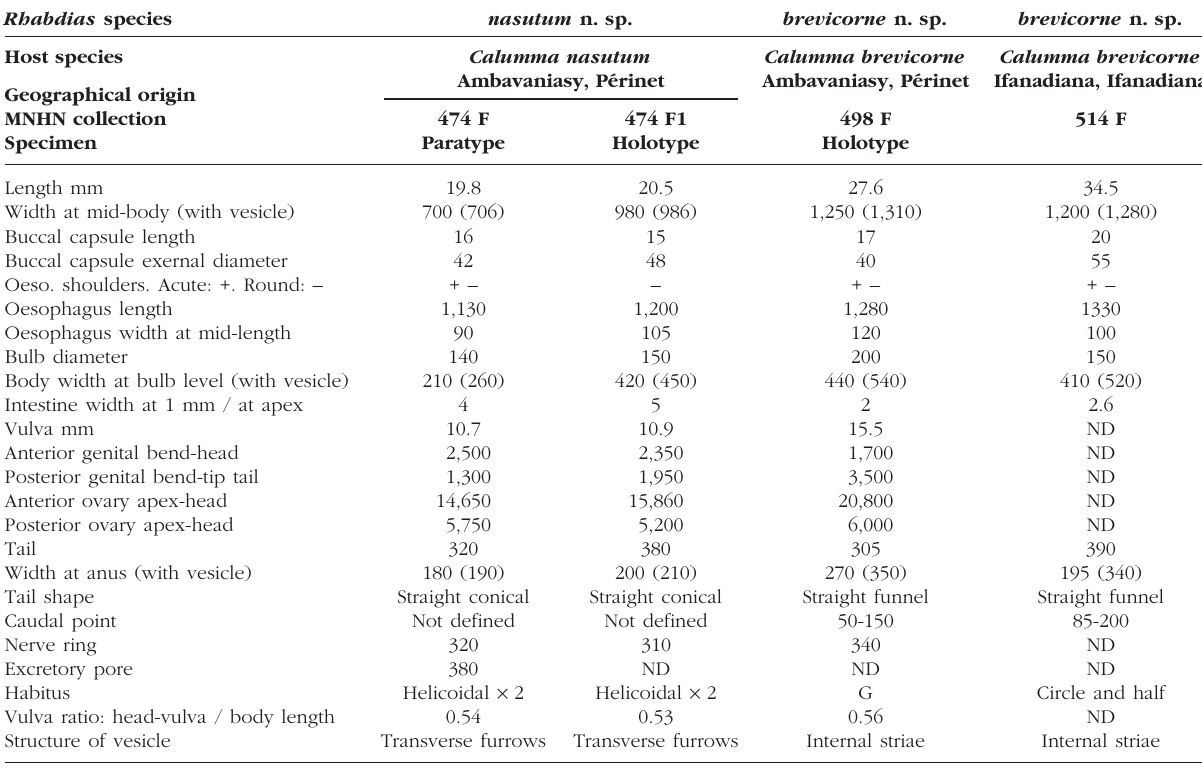
Table III. – Rhabdias nasutum n. sp. and R. brevicorne n. sp. from Calumma nasutum and Calumma brevicorne , respectively, from the eastern region,